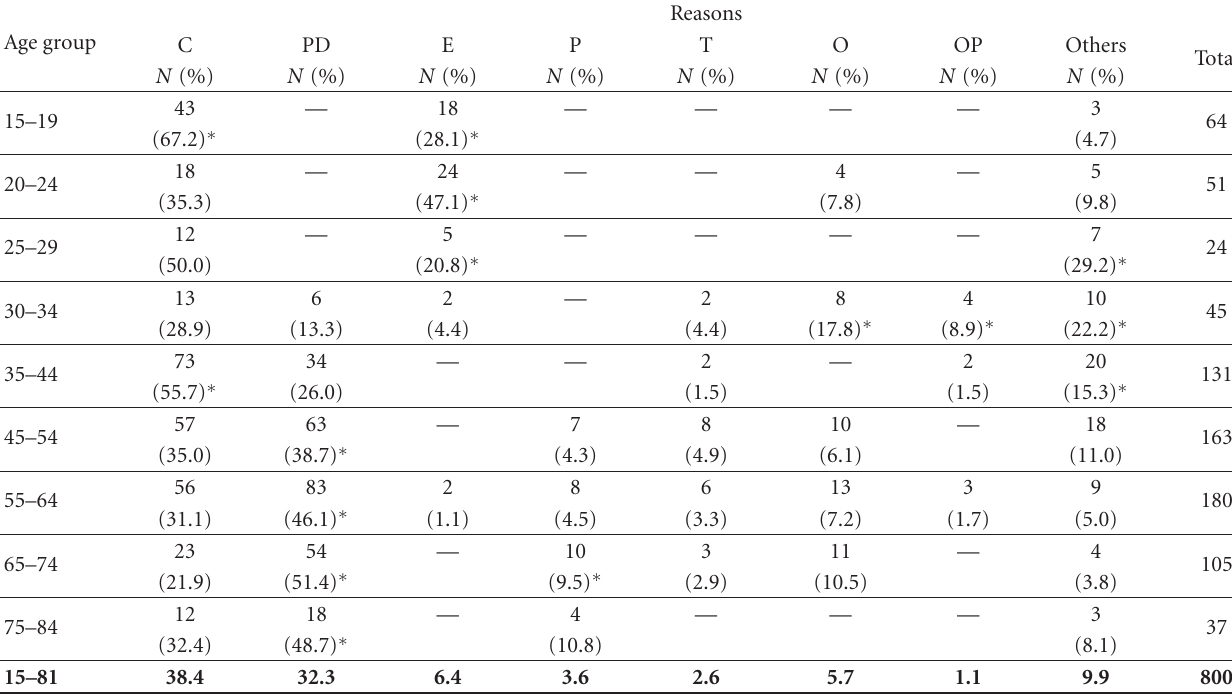
Table 6: Reasons for tooth extraction by age